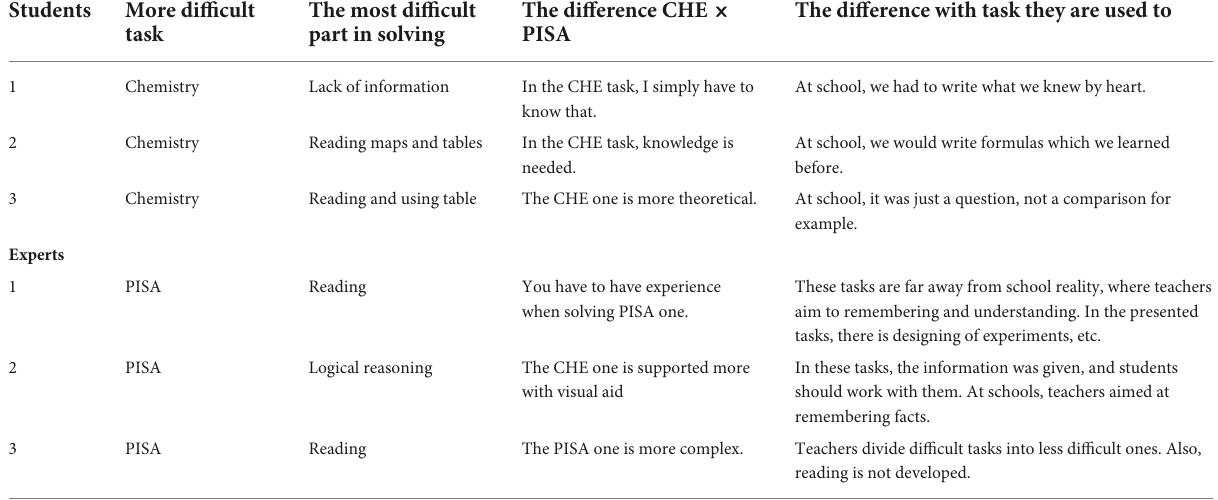
TABLE 4 Perceived task difficulty and